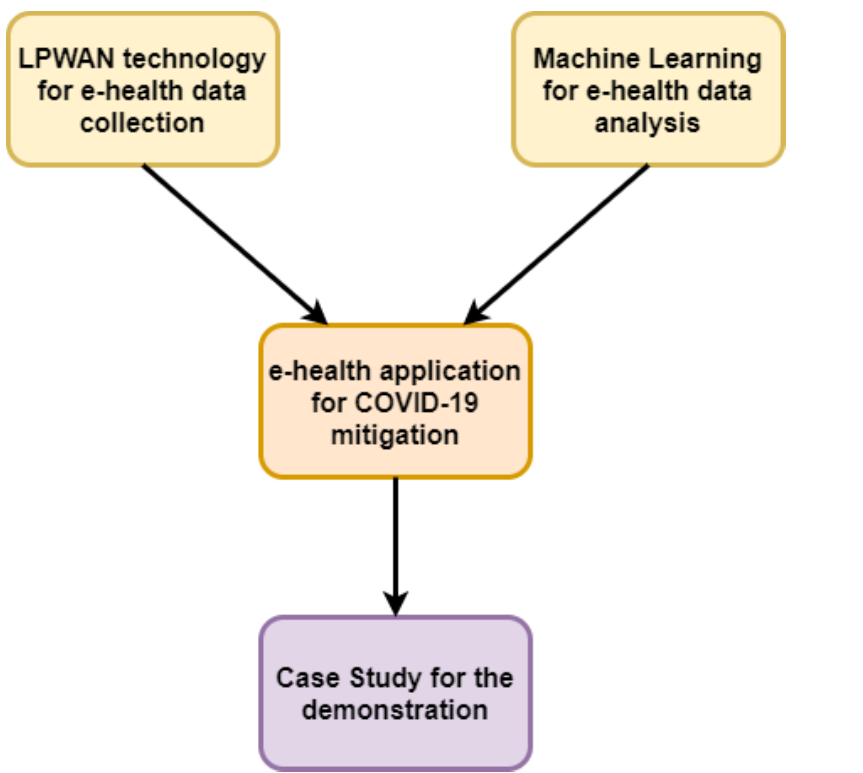
Figure 1. Block diagram of our research